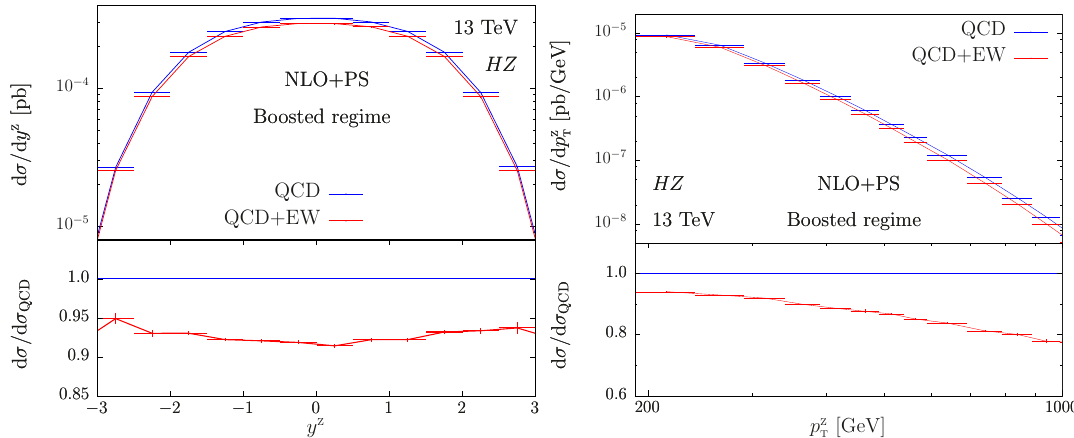
Figure 17. NLO+PS predictions for the rapidity (left) and the transverse momentum (right) of the Z boson for HZ production in the boosted regime. Same curves and labels as in (cid:12)gure 15.